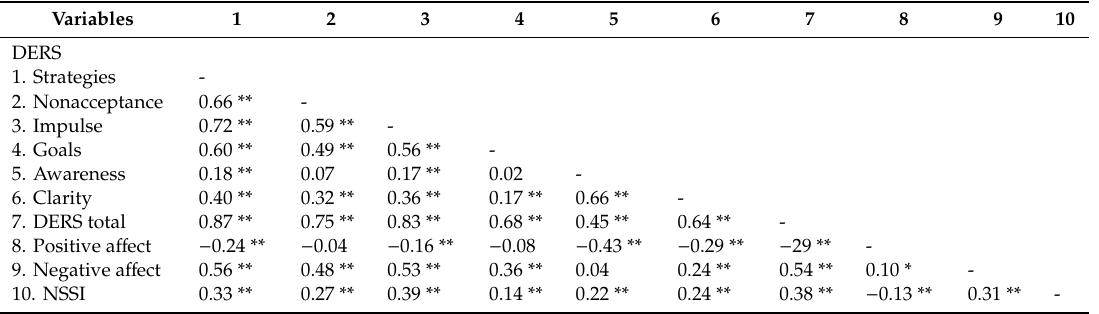
Table 1. Correlations between non-suicidal self-injury (NSSI) and other research variables ( n = 438)